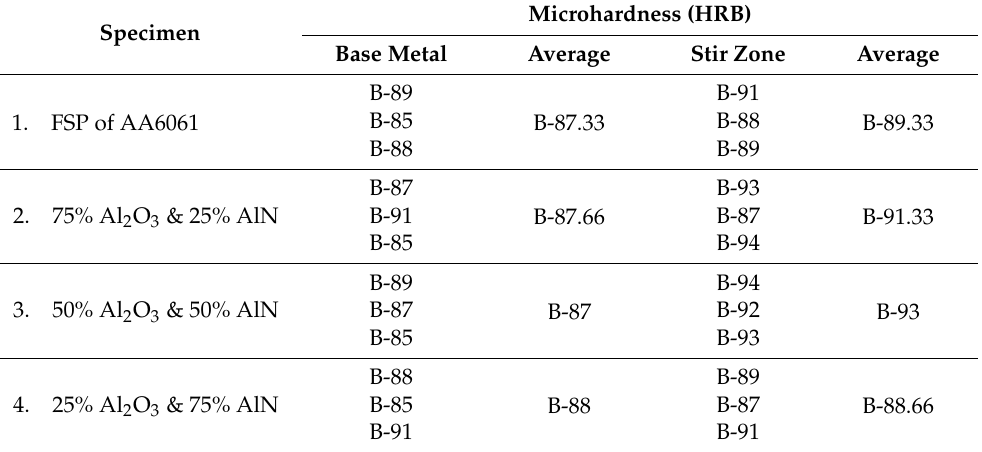
Table 1. Hardness value of AA6061 reinforced with Al 2 O 3 and AlN [38]. Specimen Base